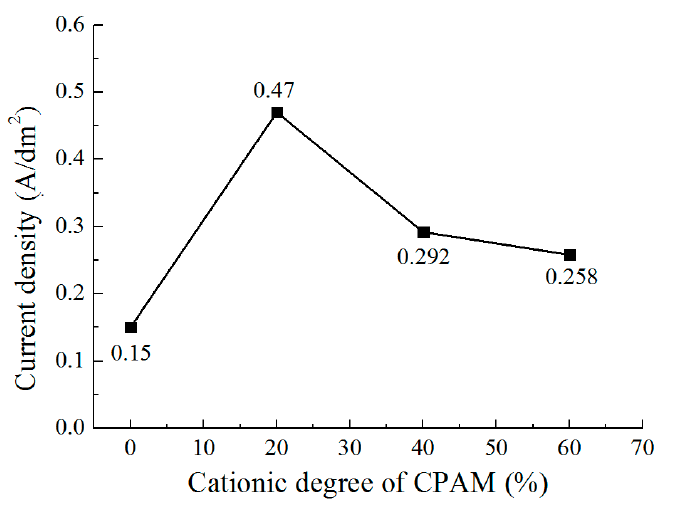
Figure 4. The current density during deposition with different cationic degrees.